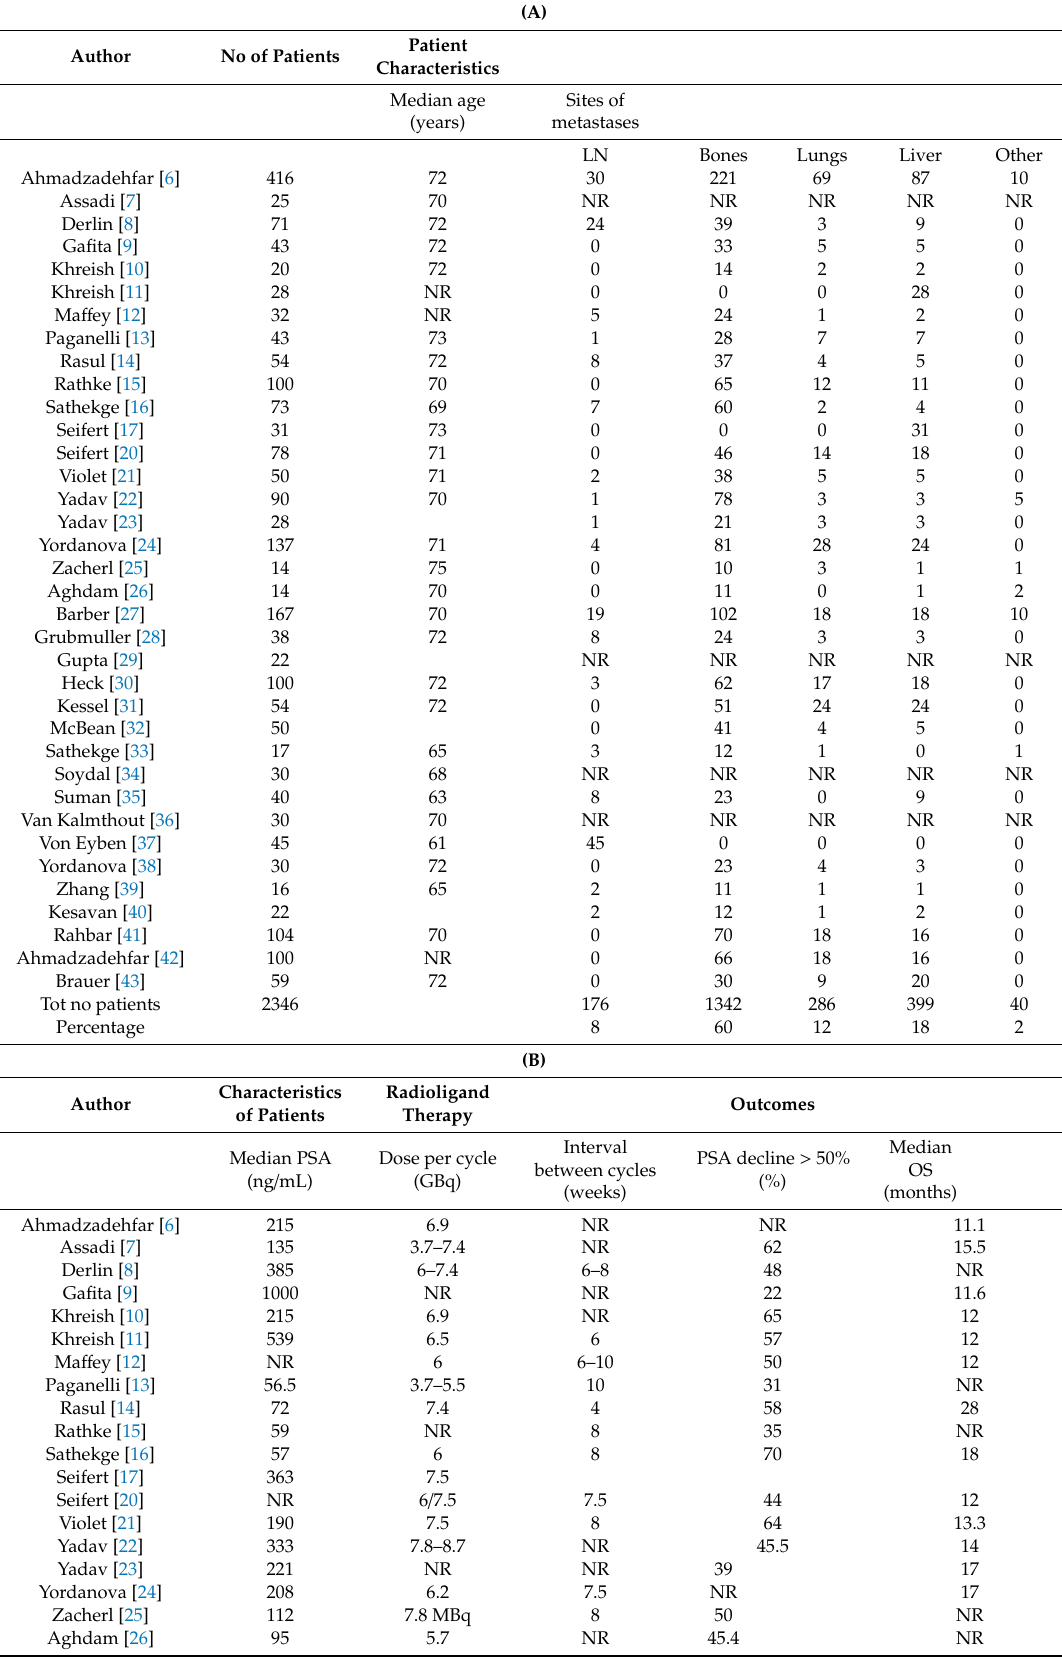
Table 1. ( A ) Characteristics in the publications. ( B ). Characteristics in the